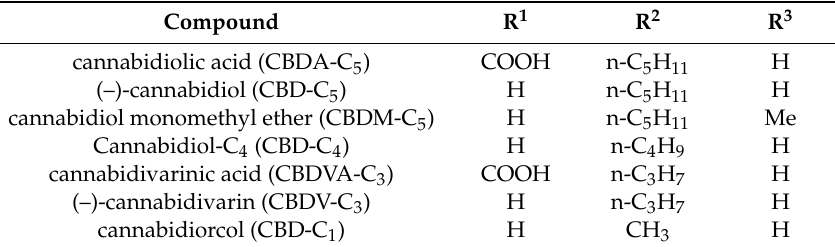
Table 1. Cannabidiol derivatives